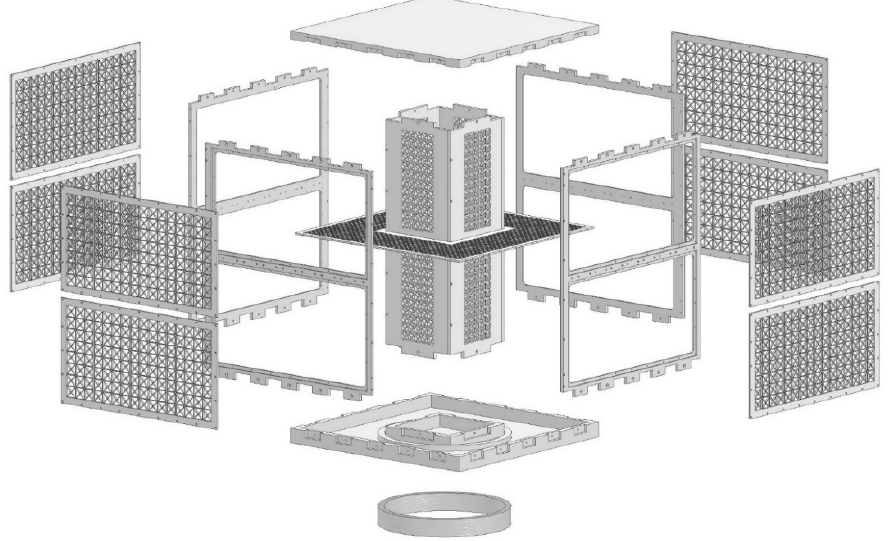
Figure 3. Exploded view of the finalized perforated assembly.